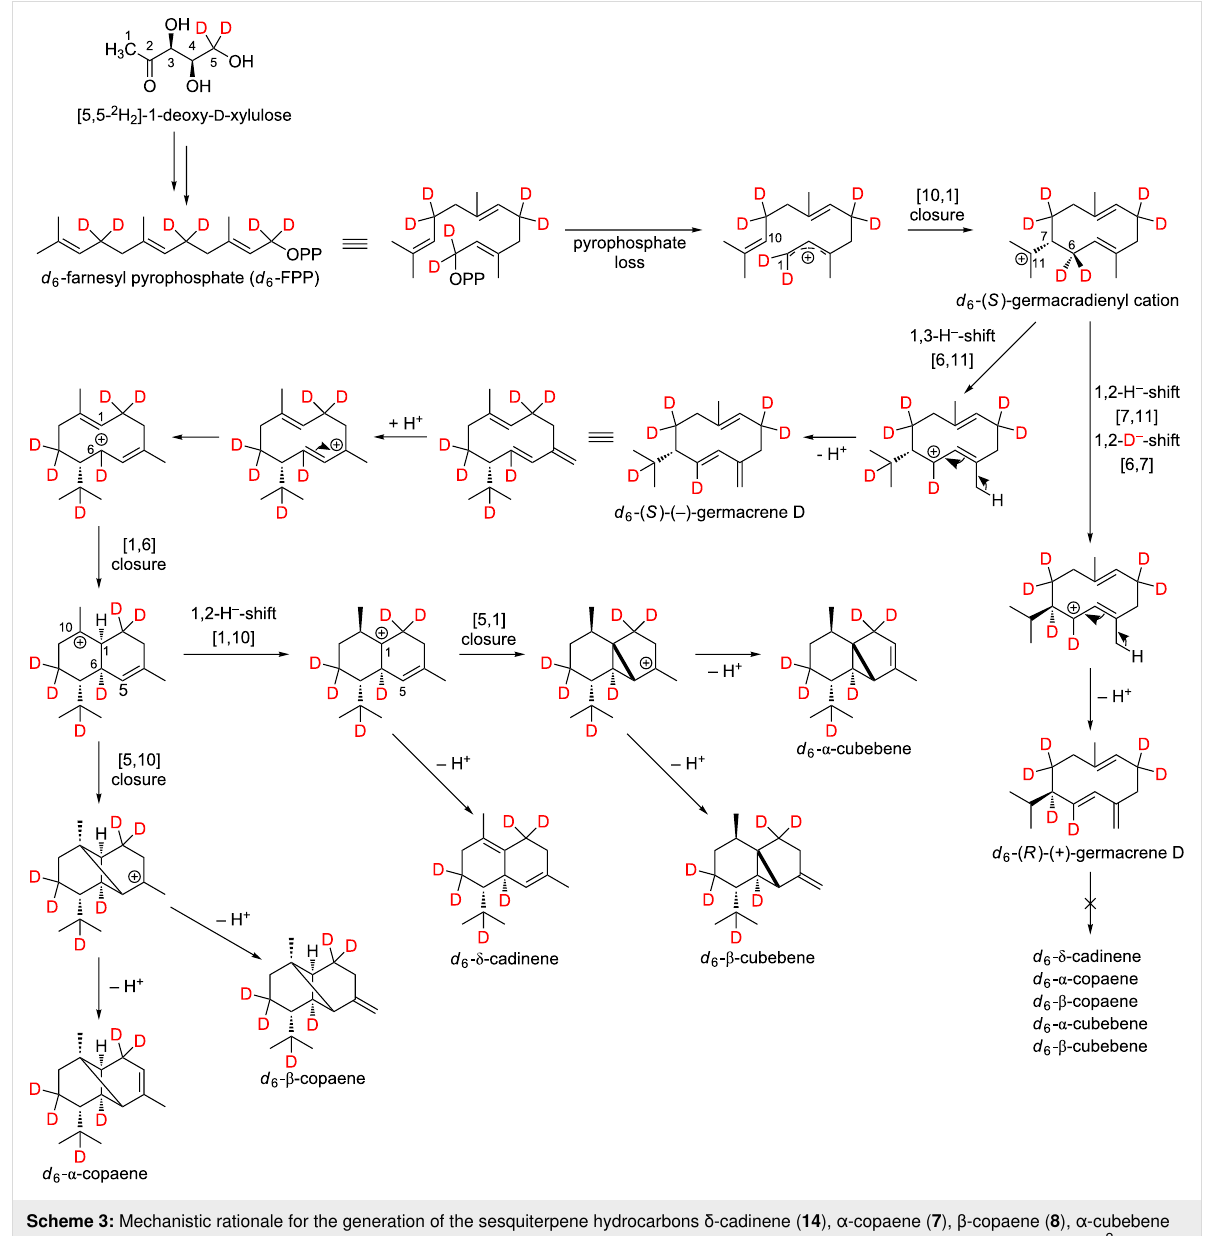
Scheme 3: Mechanistic rationale for the generation of the sesquiterpene hydrocarbons δ -cadinene ( 14 ), α -copaene ( 7 ), β -copaene ( 8 ), α -cubebene ( 10 ) and β -cubebene ( 11 ) via ( S )-( − )-germacrene D after feeding isolated exocarp of grapes using the stable isotope-labeled precursor [5,5- 2 H 2 ]-1- deoxy- ᴅ -xylulose ( d 2